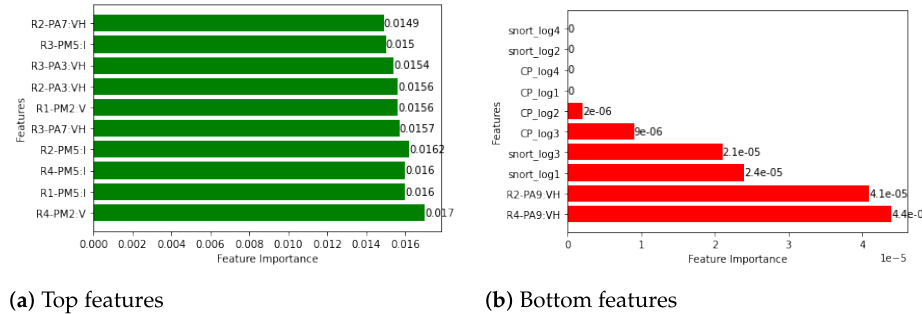
Figure 5. Ten top and bottom features with individual score using wrapper method Table 4: Water Treatment Plant: Ten top and bottom features with its importance value using Filter and Wrapper method